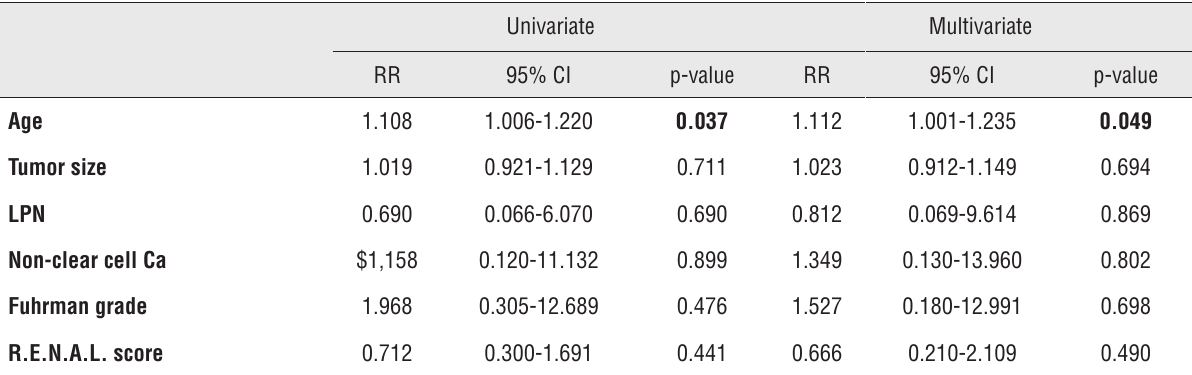
Table 3 - Results of the univariate and multivariate Cox regression analysis of the factors that may affect the disease-free survival.